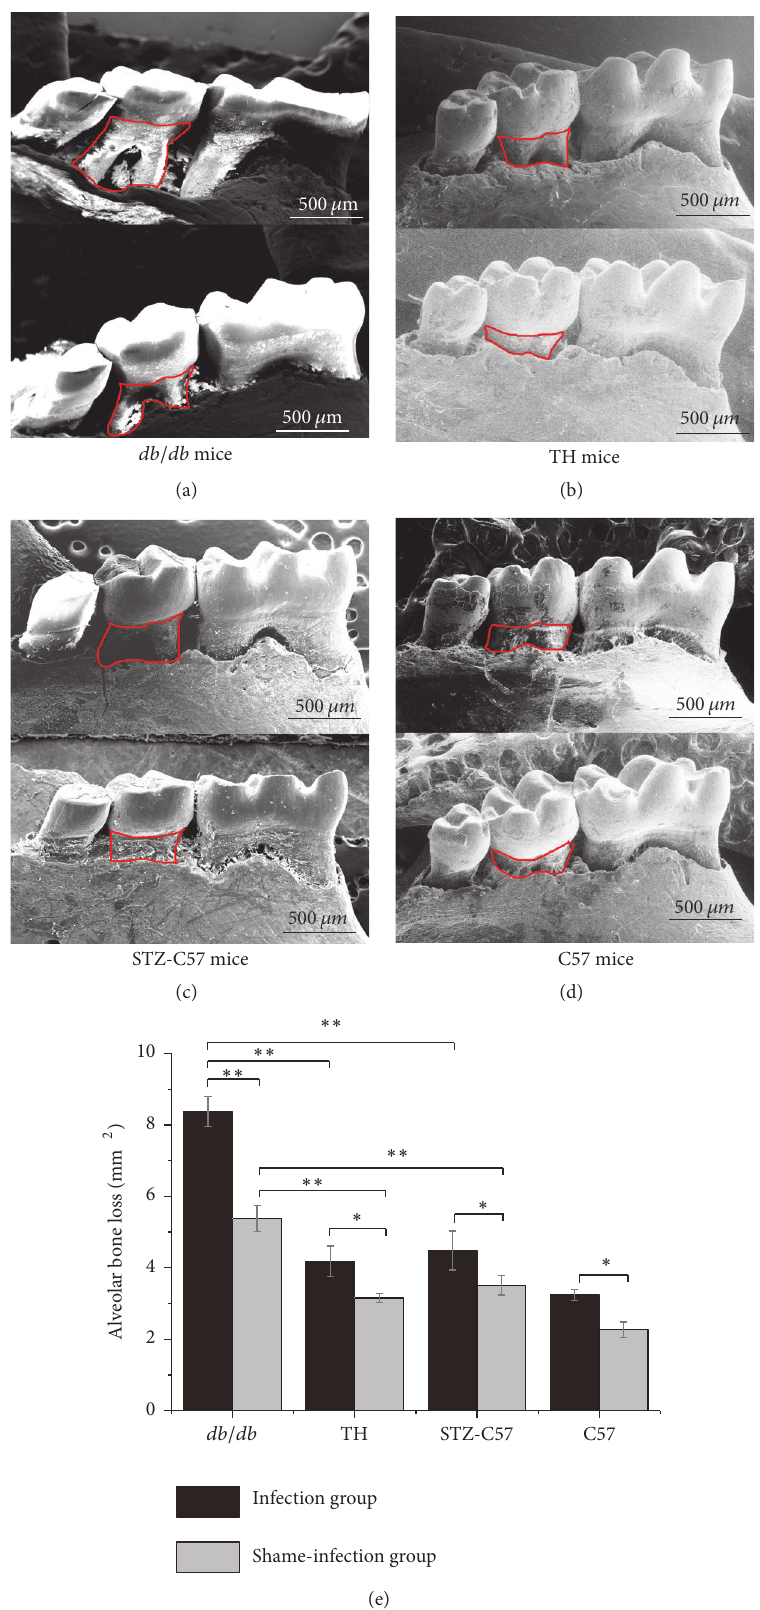
Figure 3: SEM images of mandibular jaws from mice in all groups: (a) db/db mice; (b) TH mice; (c) STZ-C57 mice; (d) C57 mice. Area within the red line was calculated as bone loss on the lingual sides of the mandibular second molars. (e) Comparison of alveolar bone loss level in different mouse models ( ∗ 𝑃 < 0.05 ; ∗∗ 𝑃 < 0.01